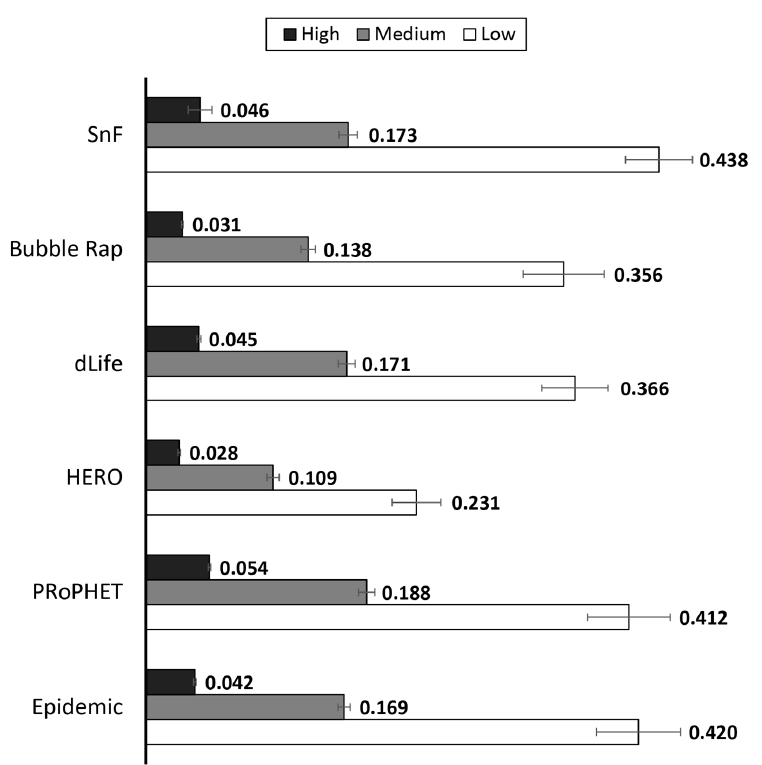
Figure 5. Throughput under low, medium and high degrees of spatial locality.